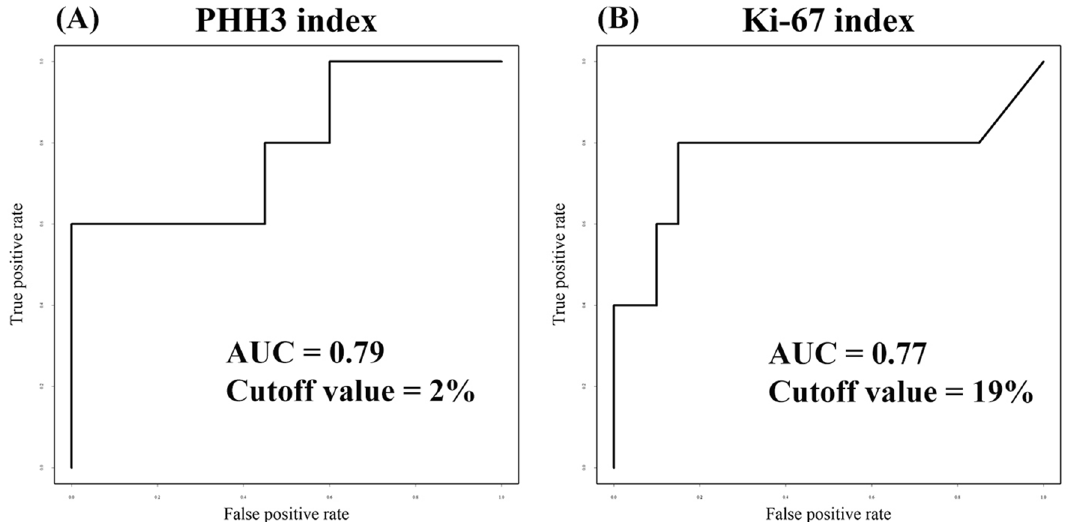
Figure 2. ROC curves of ( A ) PHH3 index and ( B ) Ki-67 index. Each cut-off value of the highest sensitivity and specificity is